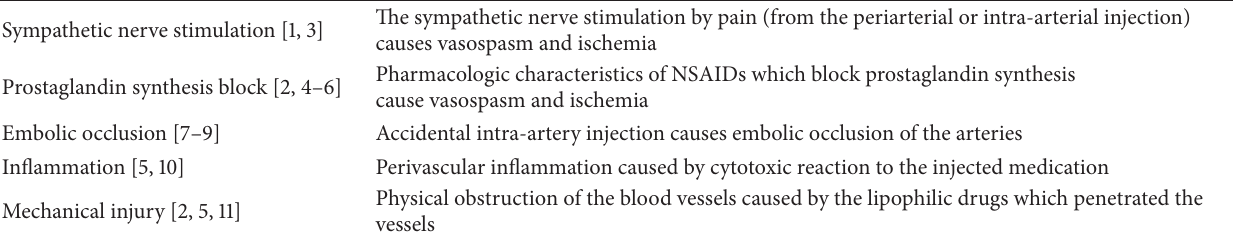
Table 1: Different theories for pathogenesis of the Nicolau